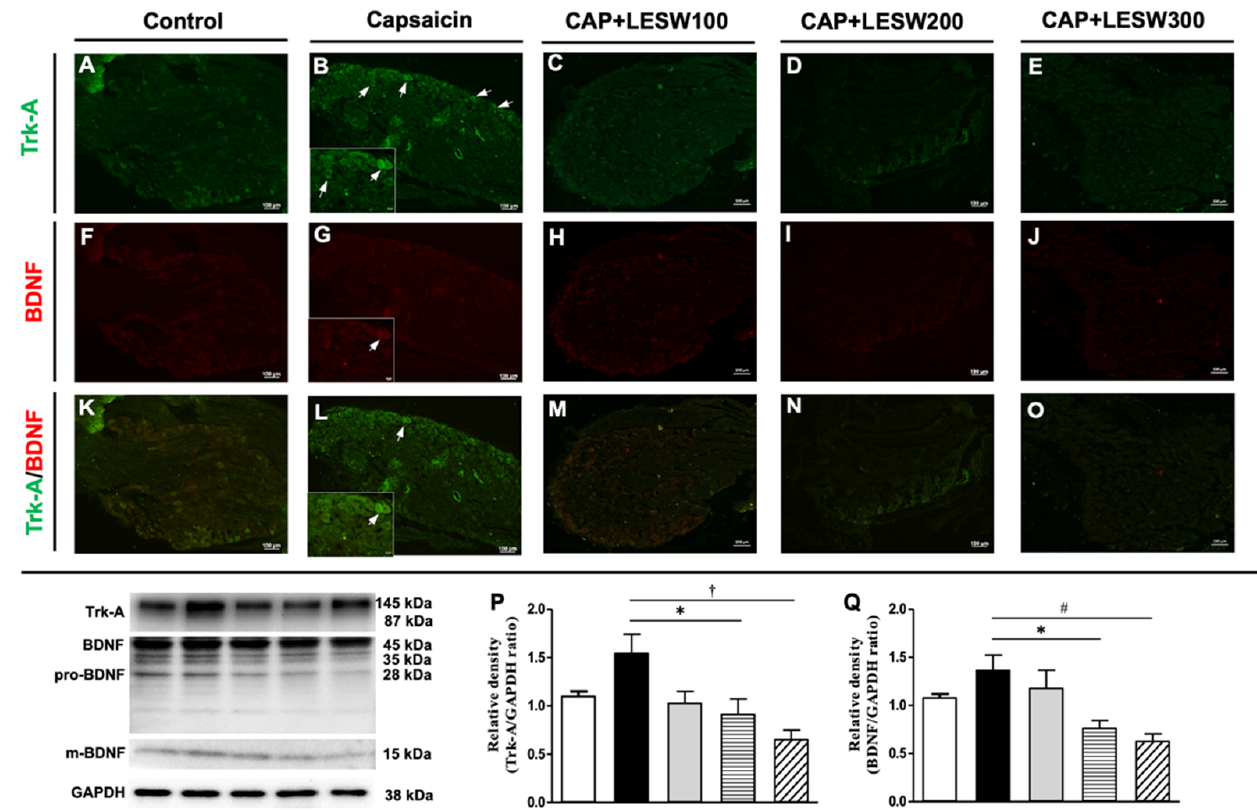
Figure 3. Immunofluorescence staining and Western blots analysis of L6 DRG three days after intraprostatic capsaicin (CAP) injection. Double immunostaining showed that Trk-A immunoreactivity (green staining) was co-localized with BDNF (red staining). Most of the BDNF-positive neurons expressed Trk-A (white arrows). Trk-A and BDNF immunoreactivity increased in intraprostatic capsaicin (CAP) injection group ( D , E , F ), which effects were attenuated by 200 and 300 shock wave treatment ( L , O ). Western blots for detecting Trk-A and BDNF expression in DRG showed consis- tent results with immunofluorescence staining. In total, 200 and 300 shocks of Li-ESWT decreased overexpression of the Trk-A and BDNF induced by intraprostatic capsaicin injection ( P , Q ). ( A – E